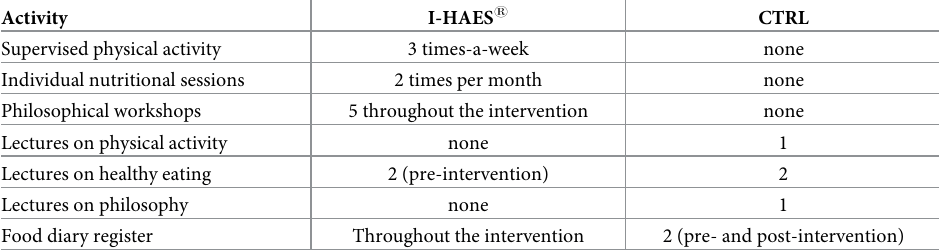
Table 1. Type and frequency of the activities performed by the intensified HAES 1 -based intervention group (I-HAES 1 ) and the control group